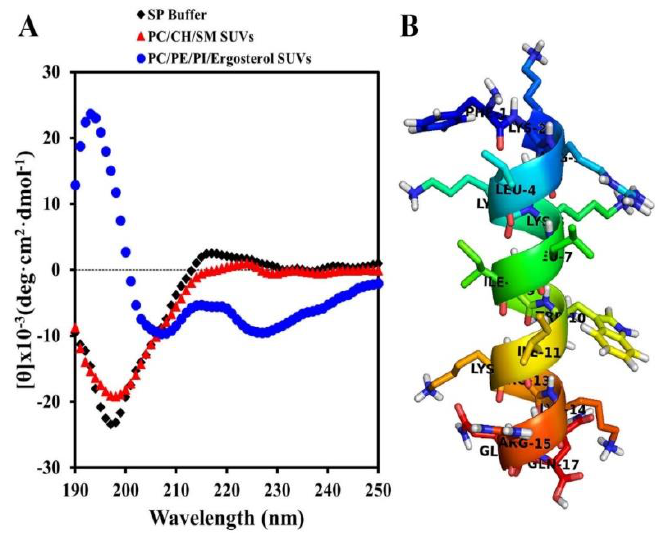
Figure 1. Secondary structures of Hn-Mc under variable conditions. ( A ) CD spectra for Hn-Mc recorded in the presence of 10 mM sodium phosphate bu ff er, PC / CH / SM (2:1:1, w / w / w) small unilamellar